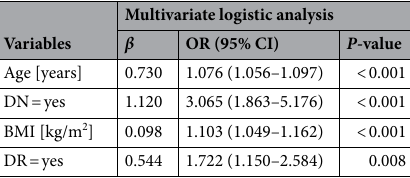
Table 3. Multivariate logistic regression analysis of step AIC selection to construct a nomogram model.